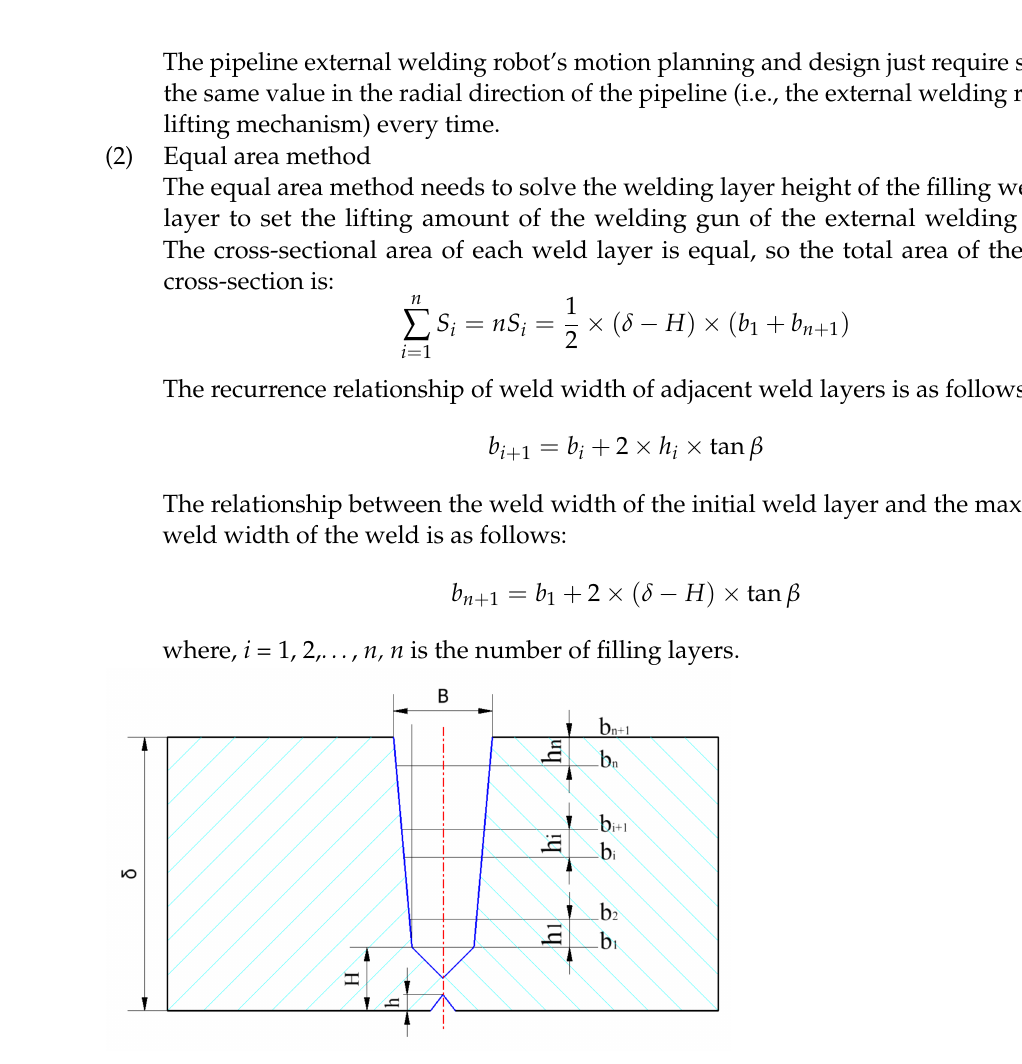
Figure 5. Filling diagram of pipeline external welding